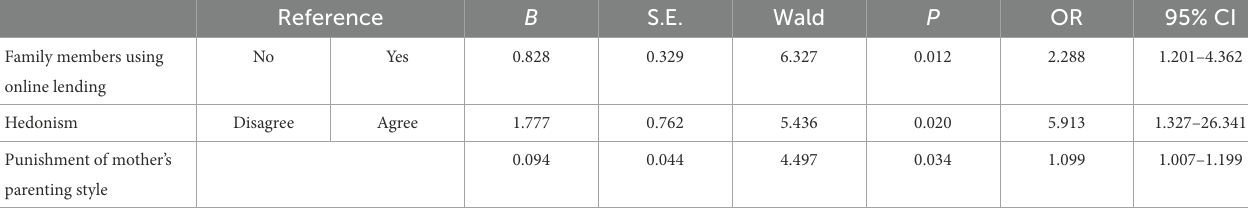
Rate of online lending